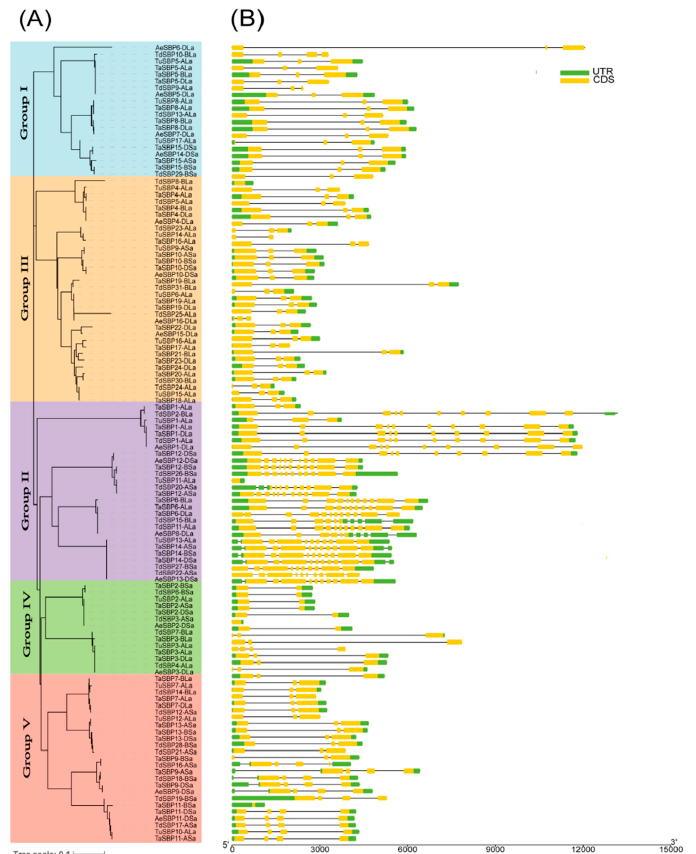
Figure 1. Comparative analysis of the phylogenetics, exon–intron structure, and conserved motifs of SBP family in wheat. ( A ) The phylogenetic tree of 120 SBP proteins (from Aegilops tauschii (16), Triticum urartu (17), Triticum dicoccoides (31), and hexaploid wheat (56, only protein translated from the splice variant “a” of each wheat SBP gene was considered here)) were constructed by using MEGA 7.0. ( B ) GSDS2.0 software was employed to generate the gene structure of 120 SBP proteins from Aegilops tauschii , Triticum urartu , Triticum dicoccoides , and hexaploid wheat. The green boxes are CDS, the black lines are introns and the yellow boxes are 5 (cid:48) Untranslated regions (UTRs) or 3 (cid:48)